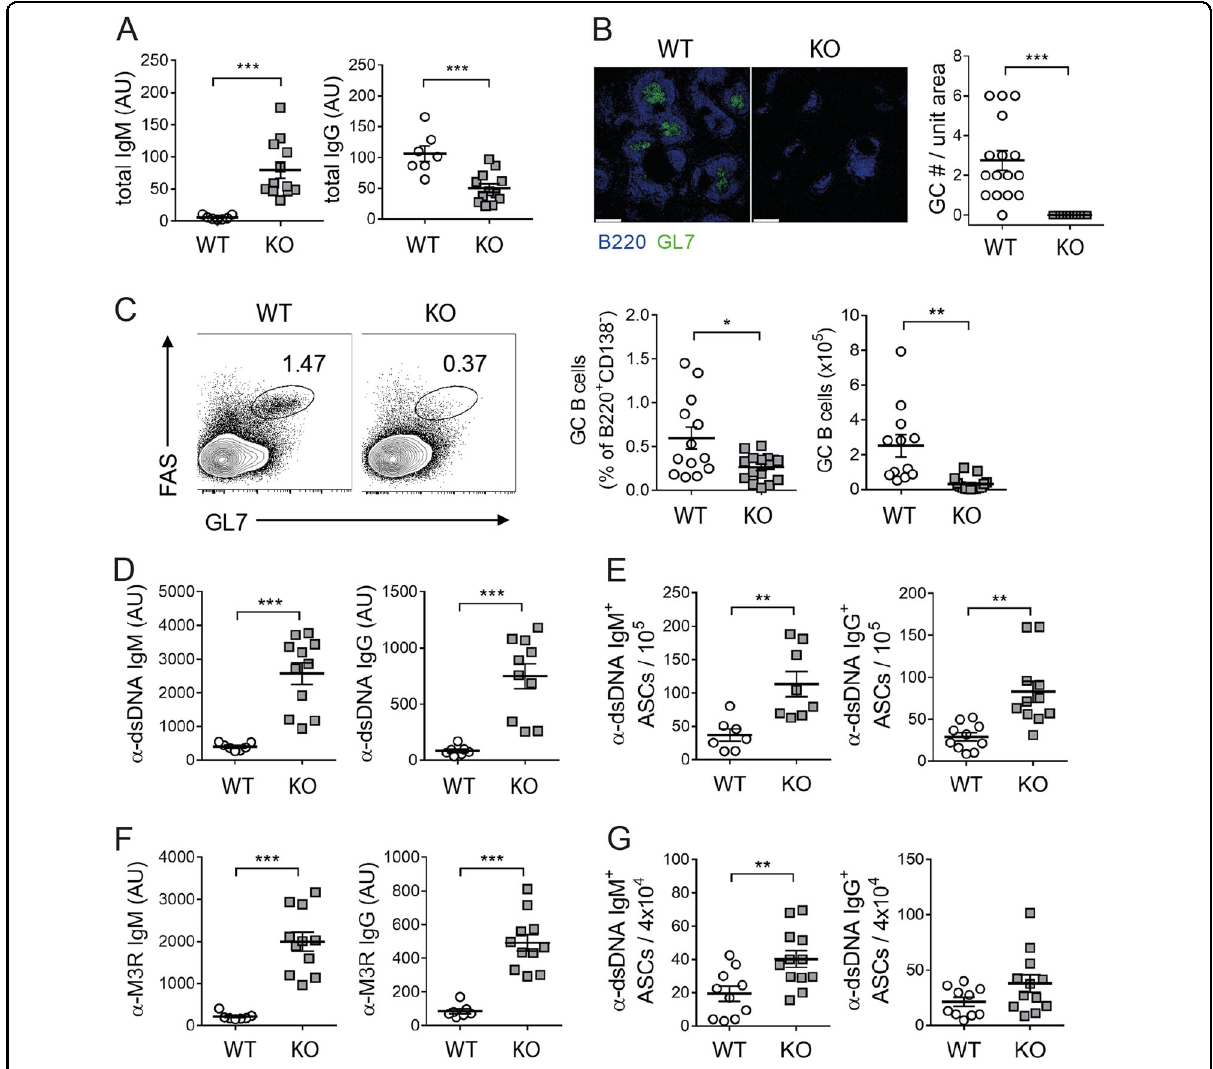
Fig. 1 Features of autoantibodies and autoantibody-secreting cells in Bach2 KO mice. The serum and spleen were collected from approximately 20-week-old Bach2 KO mice and their WT littermates. Serum was assayed by ELISA to determine titers of total IgM and IgG a , anti- dsDNA IgM and IgG d , and anti-M3R IgM and IgG f . Spleens were examined by fl uorescence confocal microscopy to detect GCs b , FACS to detect GC B cells c , and ELISPOT to count Ab-secreting cells e , g . Data are presented as the means ± SEMs in arbitrary units (AU) and Ab-secreting cells (ASCs) per indicated number of cells, pooled from three independent experiments. FACS pro fi les gated on B220 + CD138 - cells are representative of three independent experiments. Scale bar, 250 μ m. * p < 0.05, ** p < 0.01 and *** p < 0.001 by Student ’ s t